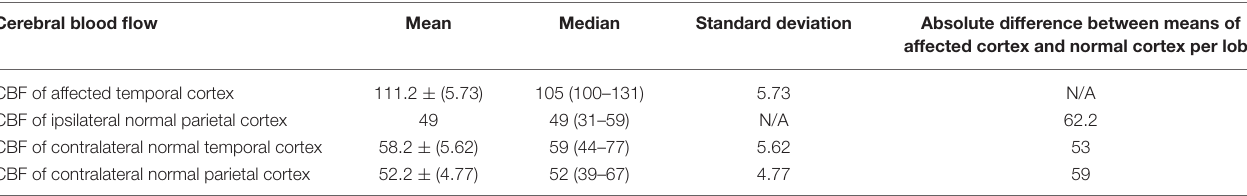
TABLE 2 | Quantitative ASL measurements by spatial location.